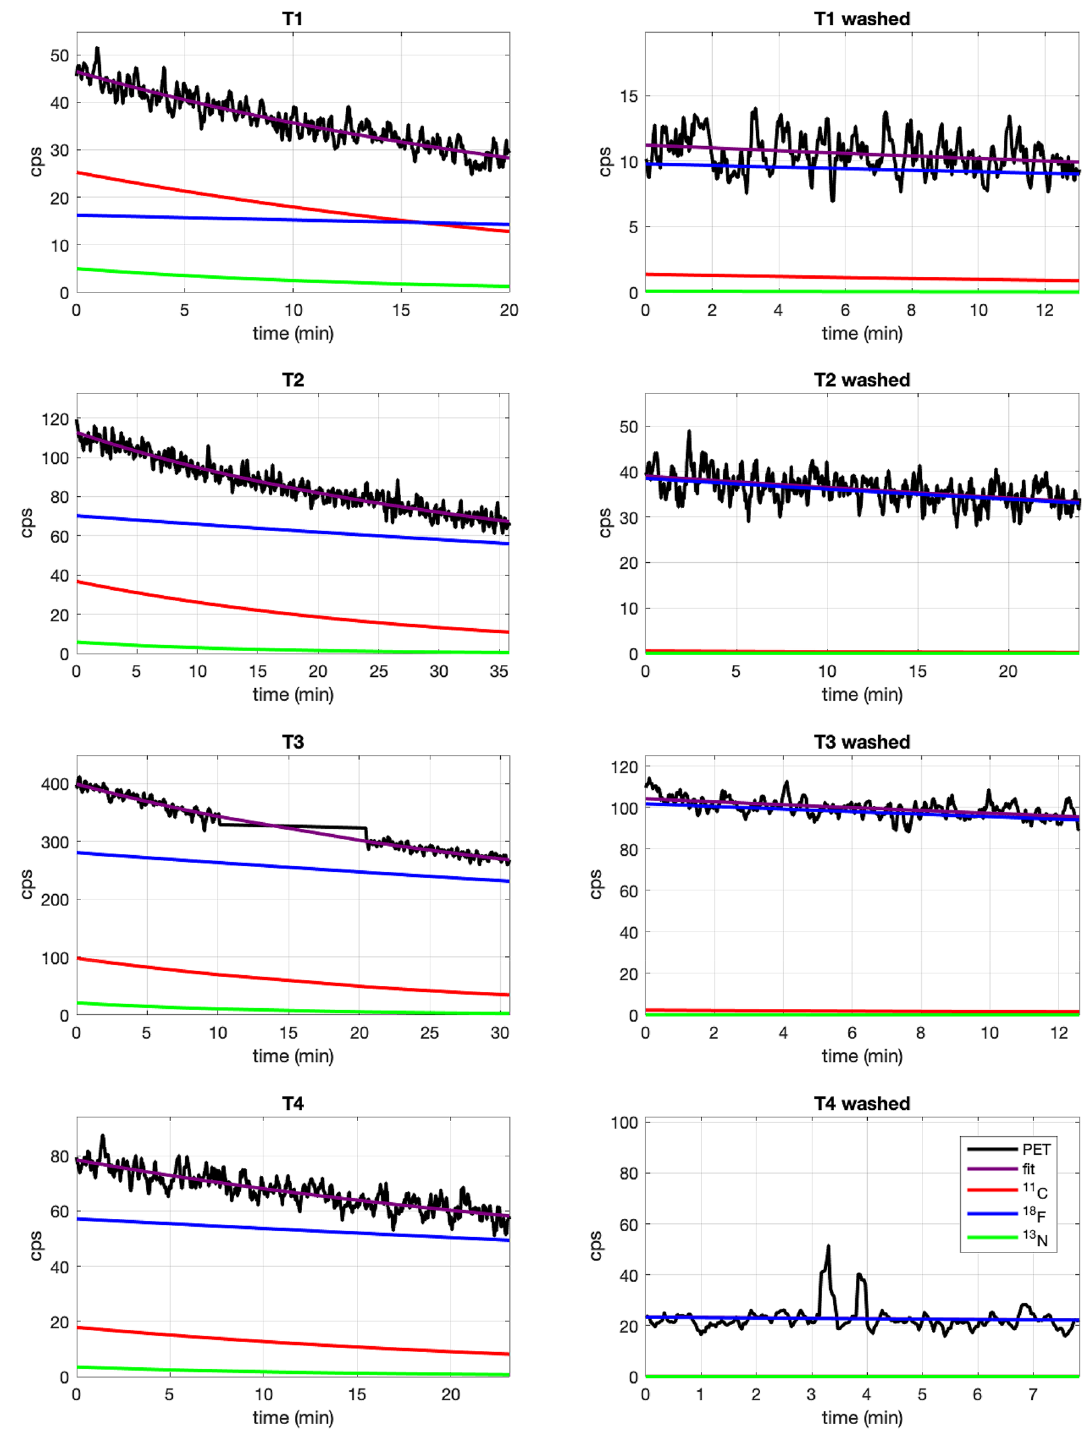
Figure 5. Decay curves (black) of gamma events recorded with the CeBr 3 detector from tumors T1–T4 inoculated with 18-W and irradiated with a proton beam before (left) and after (right) washing the tumor with PBS. Decay curves were fitted (purple) to a sum of exponentials to obtain the contribution from 11 C (red), 13 N (green) and 18 F (blue). Measurement of T3 activity was stopped for 10 min and then resumed, hence the gap in activity shown in the